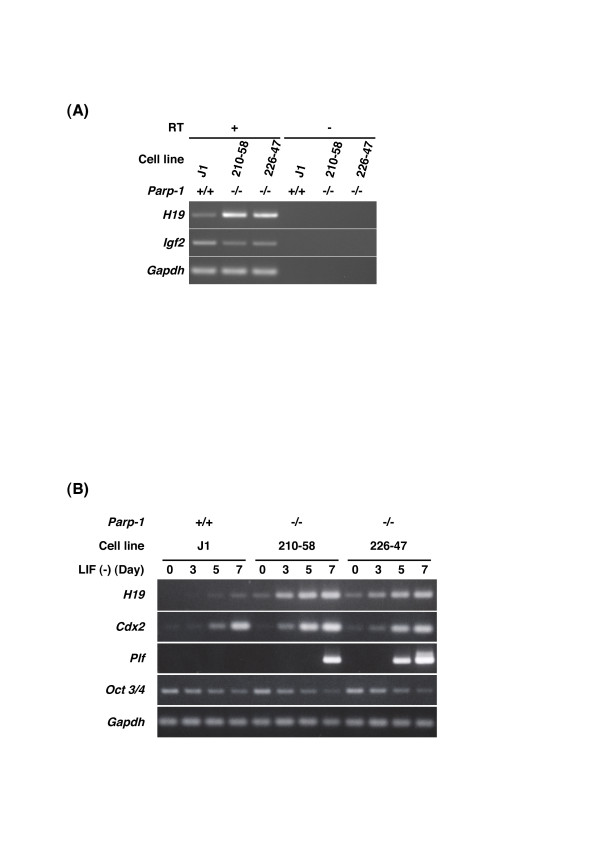
Semi-quantitative RT-PCR analysis of H19 and other extraembryonic marker gene expression in undifferentiatiated ES cells (A) or during differentiation of ES cells after LIF withdrawal (B). (A) PCR was carried out using cDNA prepared with (+) or without (-) reverse transcriptase (RT) [see Additional file 1 for primers]. (B) Total RNA was prepared using harvested ES cells 3, 5, and 7 days after removal of LIF. RNA samples prepared from untreated ES cells correspond to Day 0. Gapdh (glyceraldehyde-3-phosphate dehydrogenase) gene was used as an internal control.